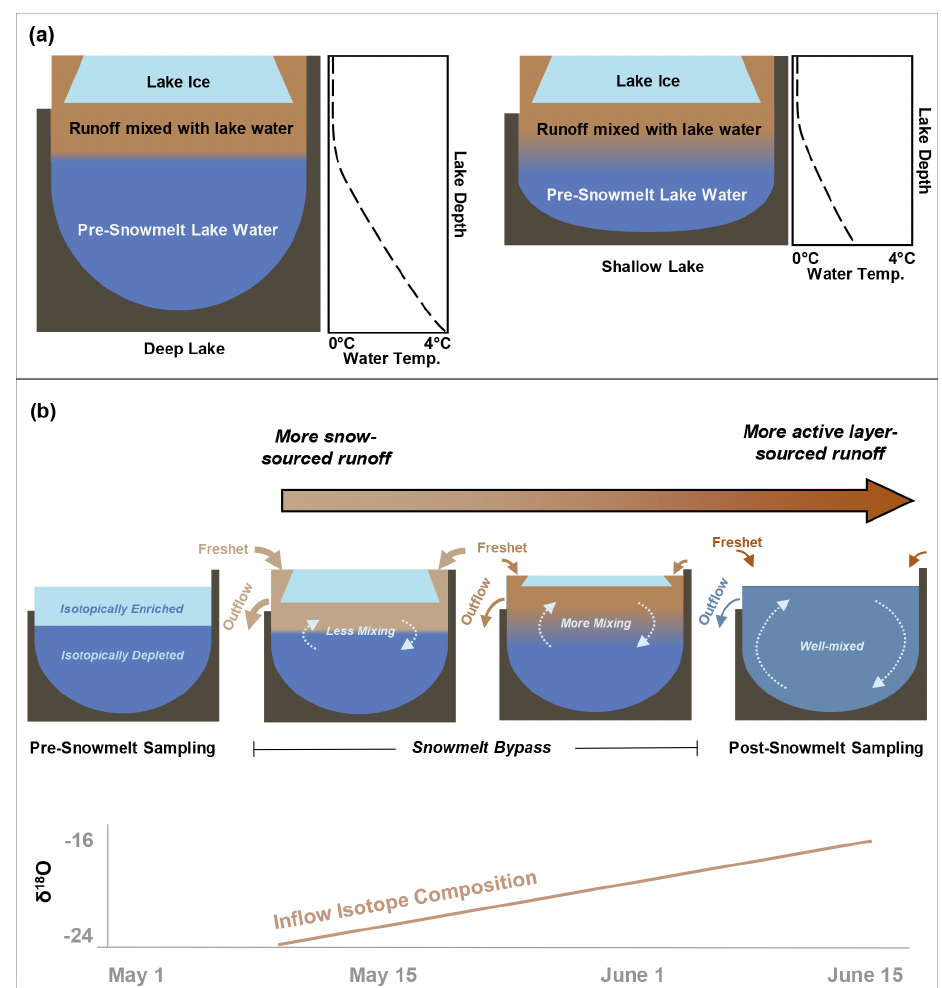
Figure 7. (a) A conceptual model showing the relative differences in snowmelt bypass between a shallow lake and a deep lake. Shallower lakes have a larger portion of their volume replaced by the runoff layer that flows beneath the ice, while a larger portion of water is isolated from mixing with runoff in deeper lakes. The estimated freshet layer thickness was somewhat uniform among all the lakes (Appendix E). (b) A conceptual model of how snowmelt bypass occurred over the course of the snowmelt period. Pre-snowmelt samples were taken from water beneath lake ice which was isotopically depleted in comparison to the lake ice. As time goes on, the source of freshet shifts from snow-sourced to active layer-sourced, while mixing increases beneath the lake ice